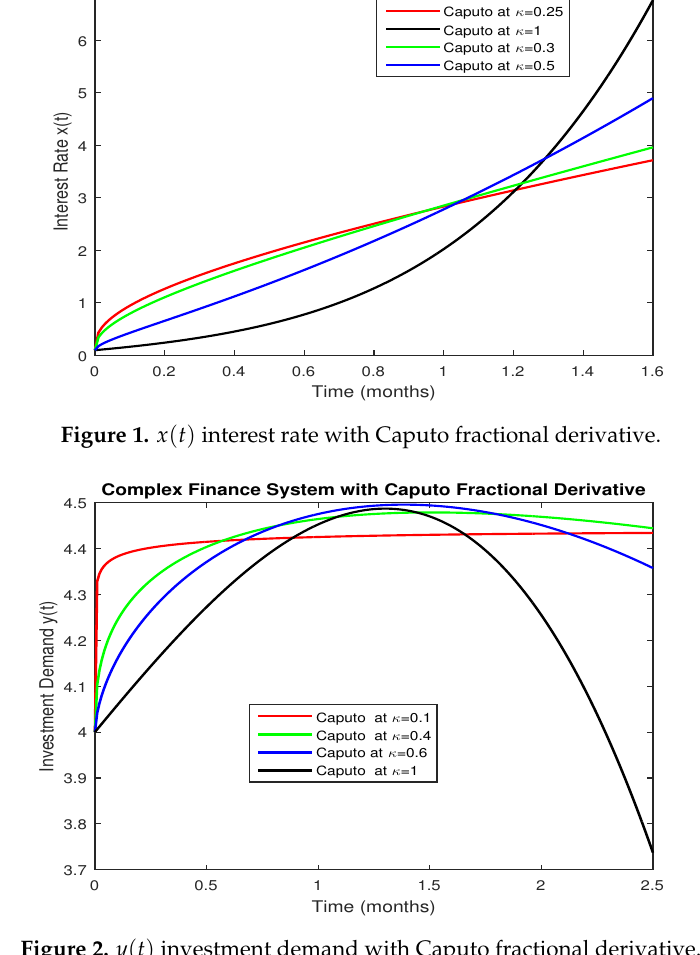
Figure 2. y ( t ) investment demand with Caputo fractional derivative.